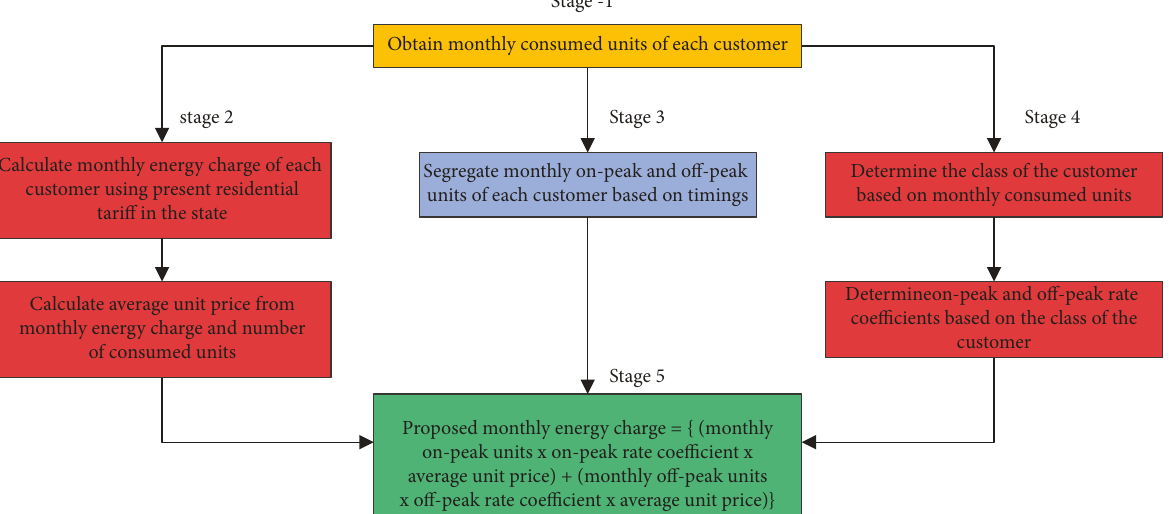
Figure 5: Methodology of the proposed rate